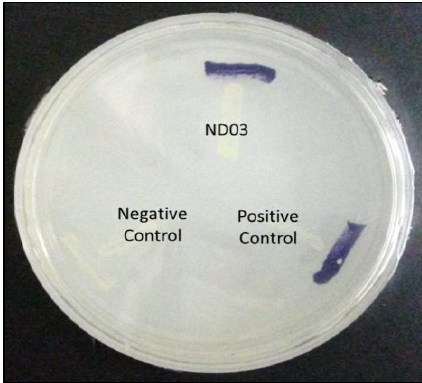
Figure 3. Detection of AHL production by Pantoea rodasii strain ND03. E. carotovora